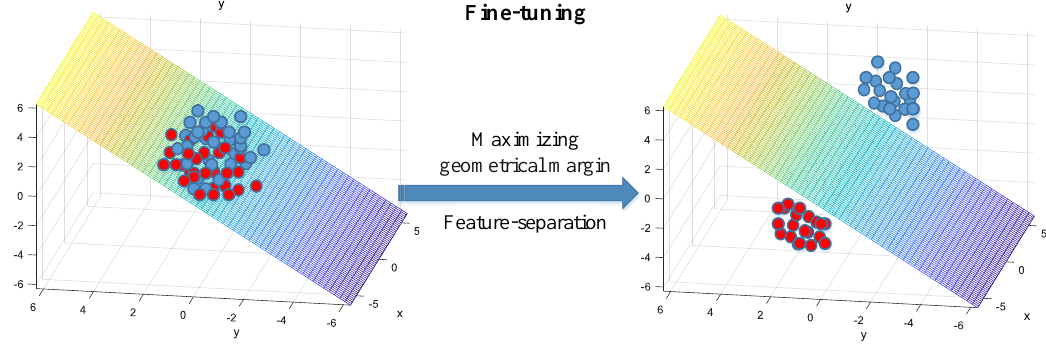
Figure 7. The process of